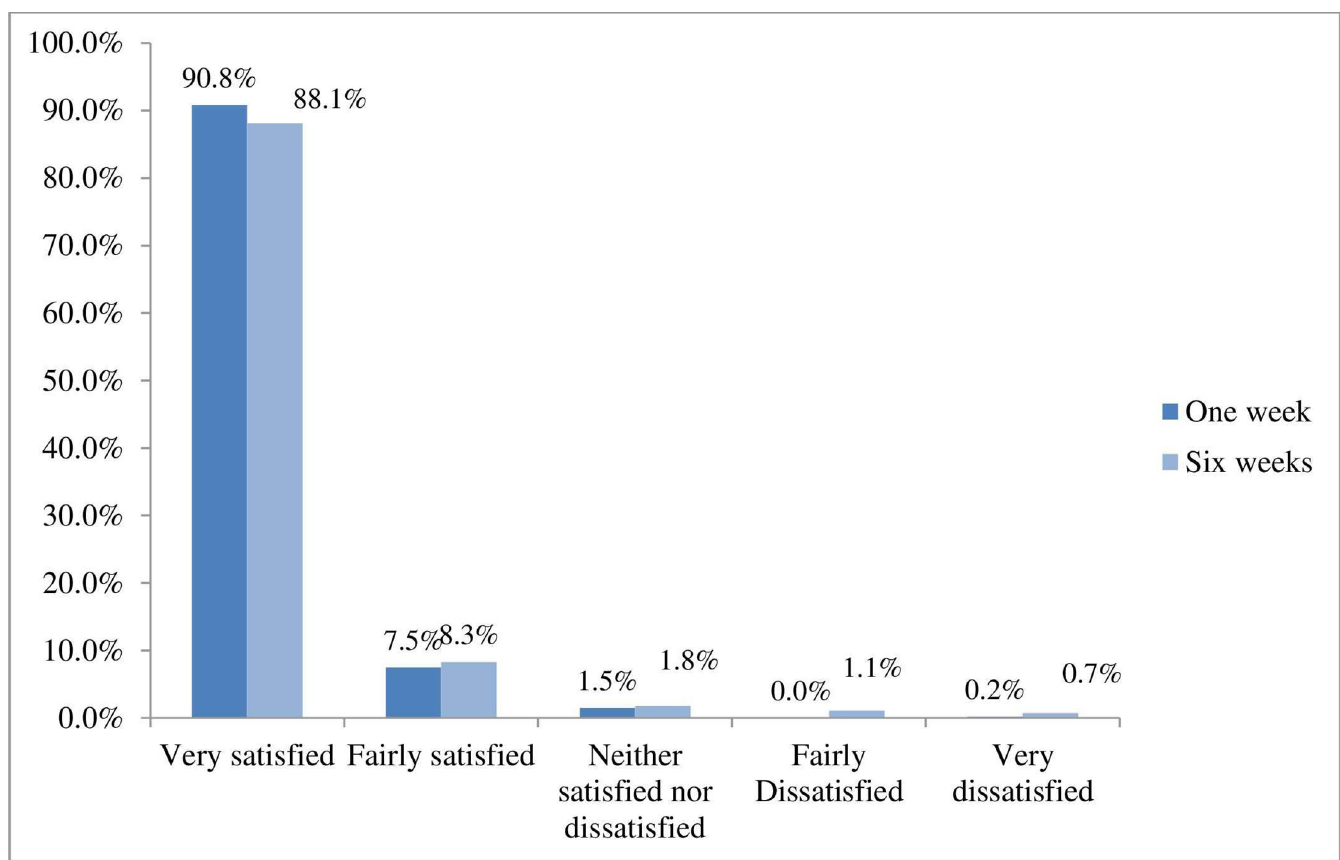
Fig 4. Patient satisfaction one week and six weeks